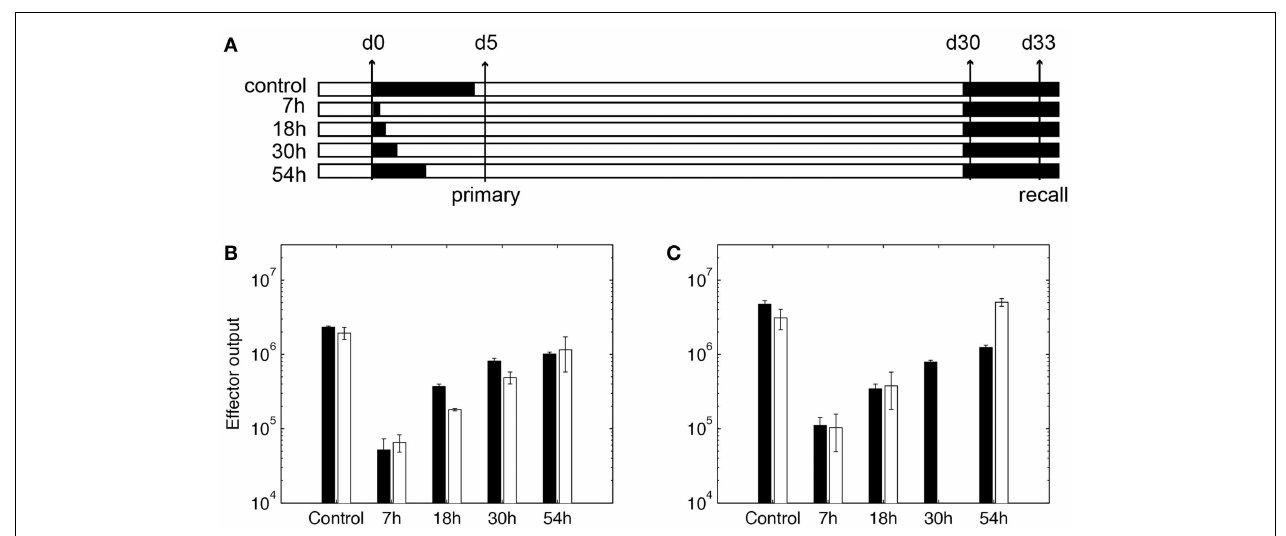
response, respectively. (B,C) CD8 + T cell population in simulated responses (black bars) and experimental data (white bars) (59). (B) Size of expanded CD8 + T cell population in primary response.Values are measured from day 5 after Ag-DC are recruited to the LN. (C) Size of expanded CD8 + T cell population during recall response on day 33. X -axis value indicates antigen presentation times in the primary